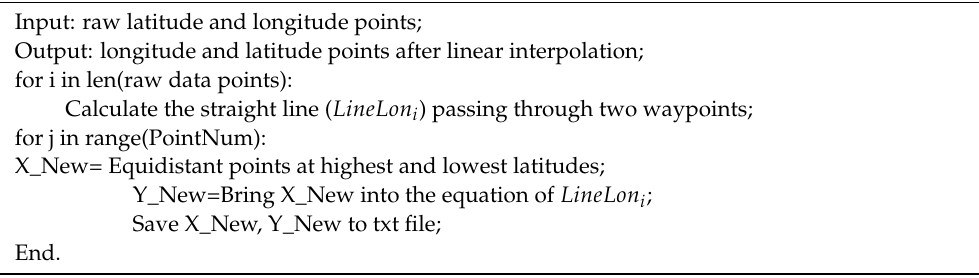
Algorithm 1: Linear interpolation algorithm between two waypoints